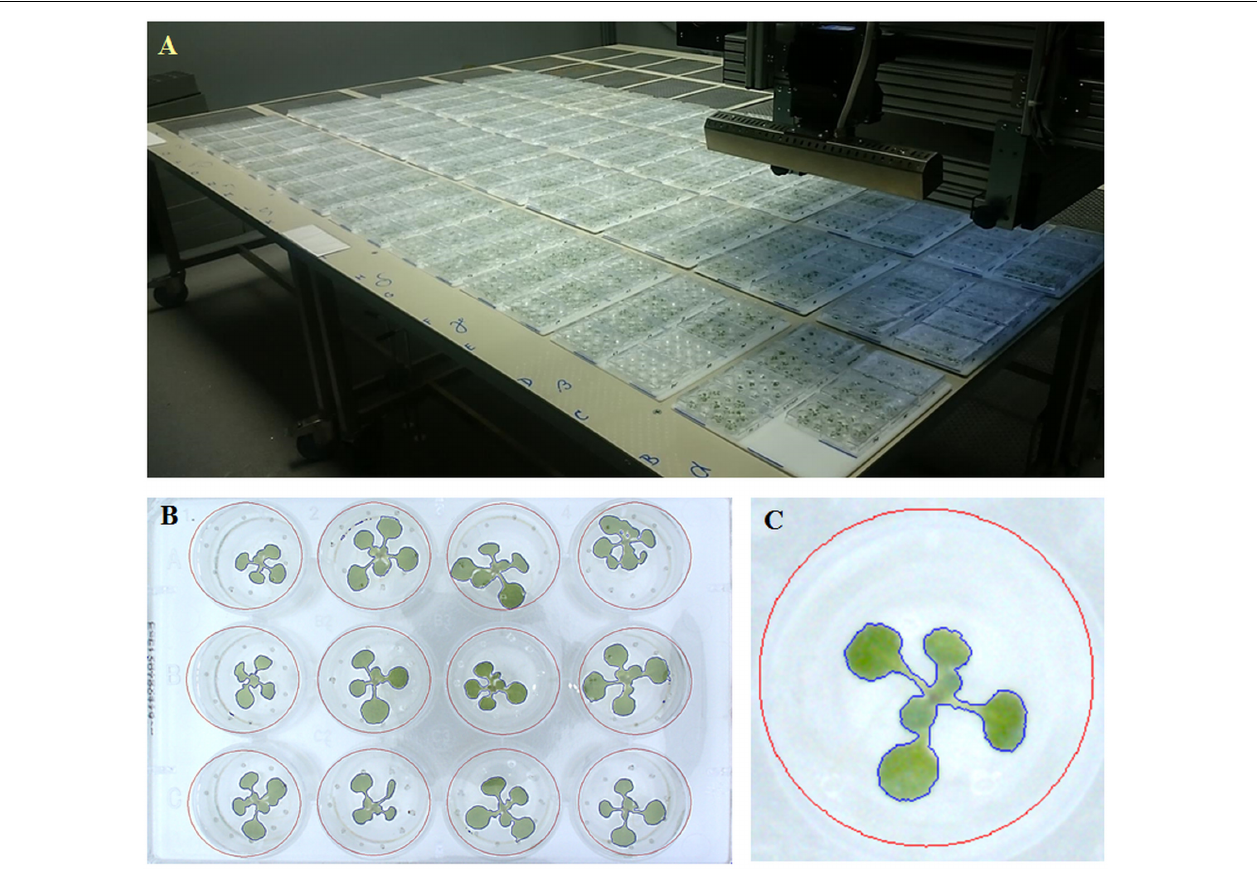
FIGURE 1 | High-throughput phenotyping platform for growing Arabidopsis in multi-well plates. (A) XYZ PlantScreen TM growth-chamber with automatic top view RGB imaging. (B) RGB images of 9 DAG old Arabidopsis seedlings. (C) RGB image of an individual well-plate with the blue boundary mark created by the in-house software for